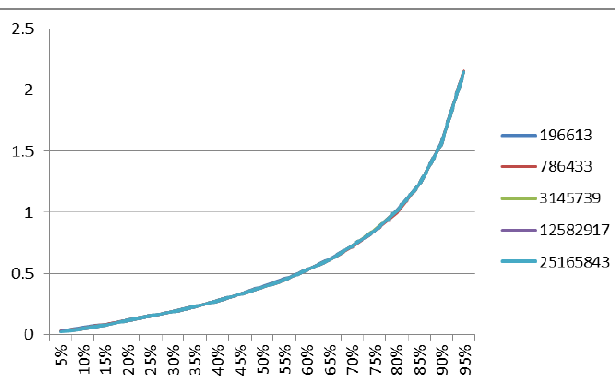
Fig. 11. Amortized collision, Murmur, linear probing, string length=13